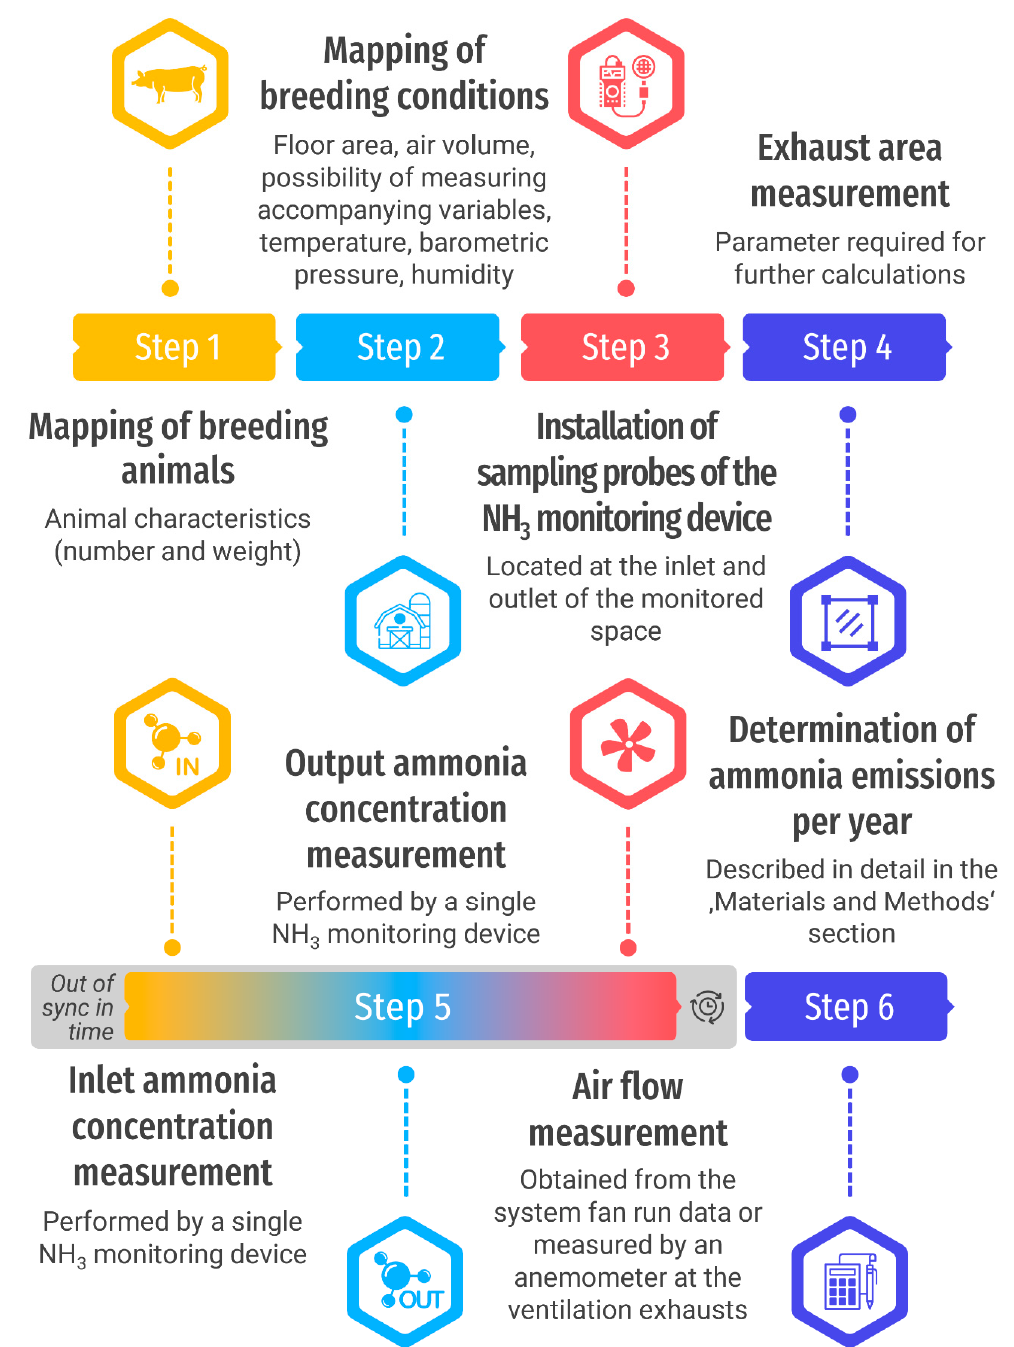
Figure 1. Scheme of measurements and determination of the ammonia emissions.